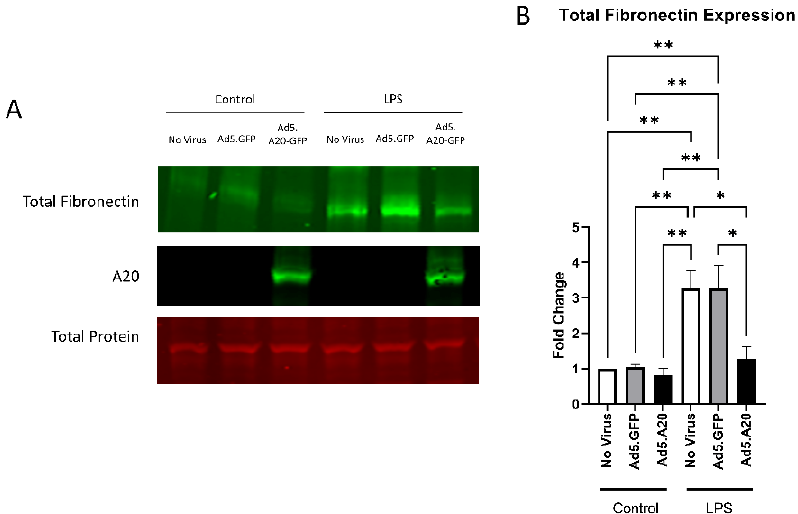
Figure 5. LPS-induced fibronectin expression is attenuated with A20 overexpression. Primary TM cells were treated with the indicated Ad.5 virus and then with LPS for 48 h. (A) Representative Western blot showing fibronectin and A20 expression, with the total protein stain used for normalization. ( B ) Fibronectin expression was greatly induced by the addition of LPS, and A20 overexpression blocked LPS-induced fibronectin expression. Statistical significance was calculated by one-way ANOVA with Tukey post-hoc analysis, with p < 0.05 considered statistically significant. Error bars show SEM. * = p ≤ 0.05, ** = p ≤ 0.01.